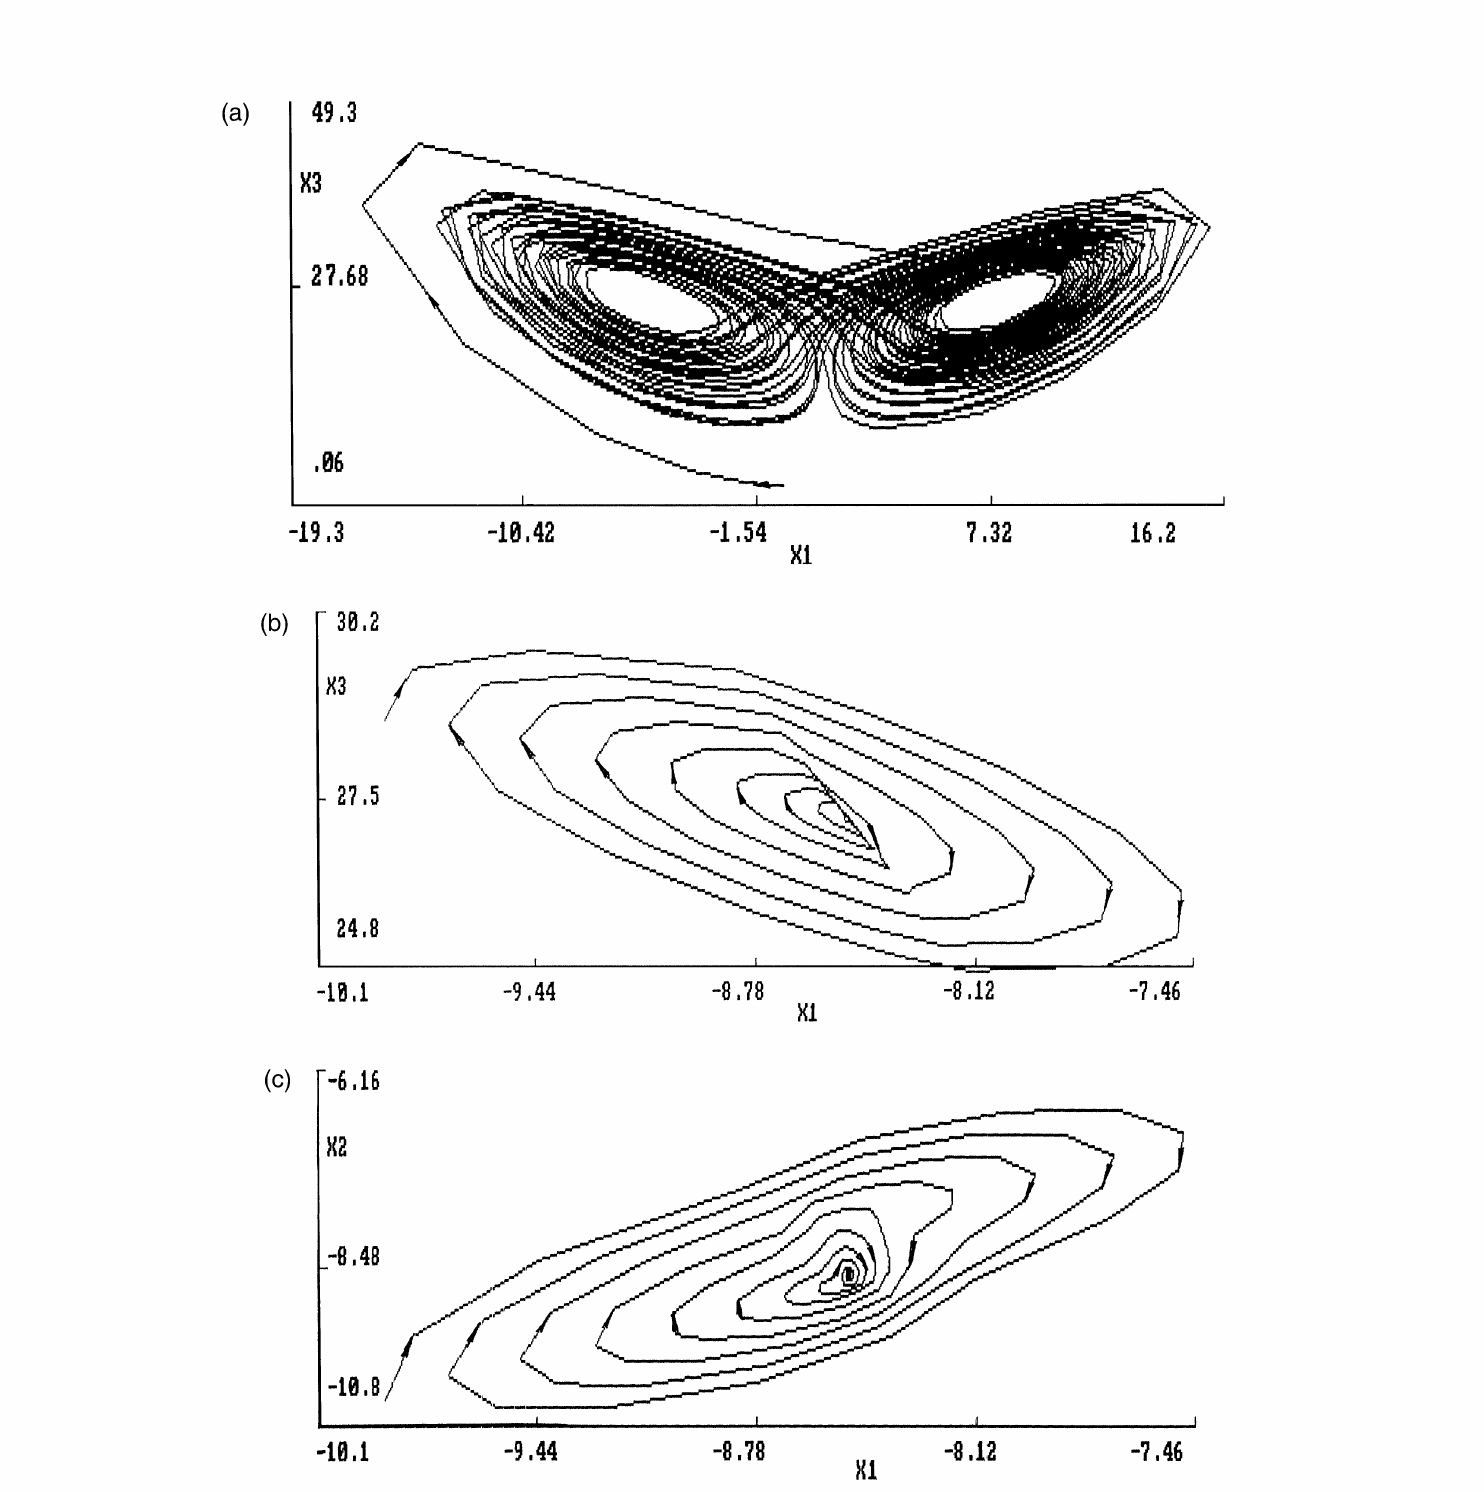
Comparison of the Lorenz attractor without control and with control, both with x(0)=(0,2,7) q- and e=4.5 (a) Projection in the x3-xl plane, without control. (b) Projection in the x3-xl plane, in which the stabilized equilibrium is Q’= (-8.54,-8.54, 27.39) q- of the Lorenz attractor controlled by (3.5) in the form of (2.2) from beginning. (c) Projection in the x2-xl plane, the same as